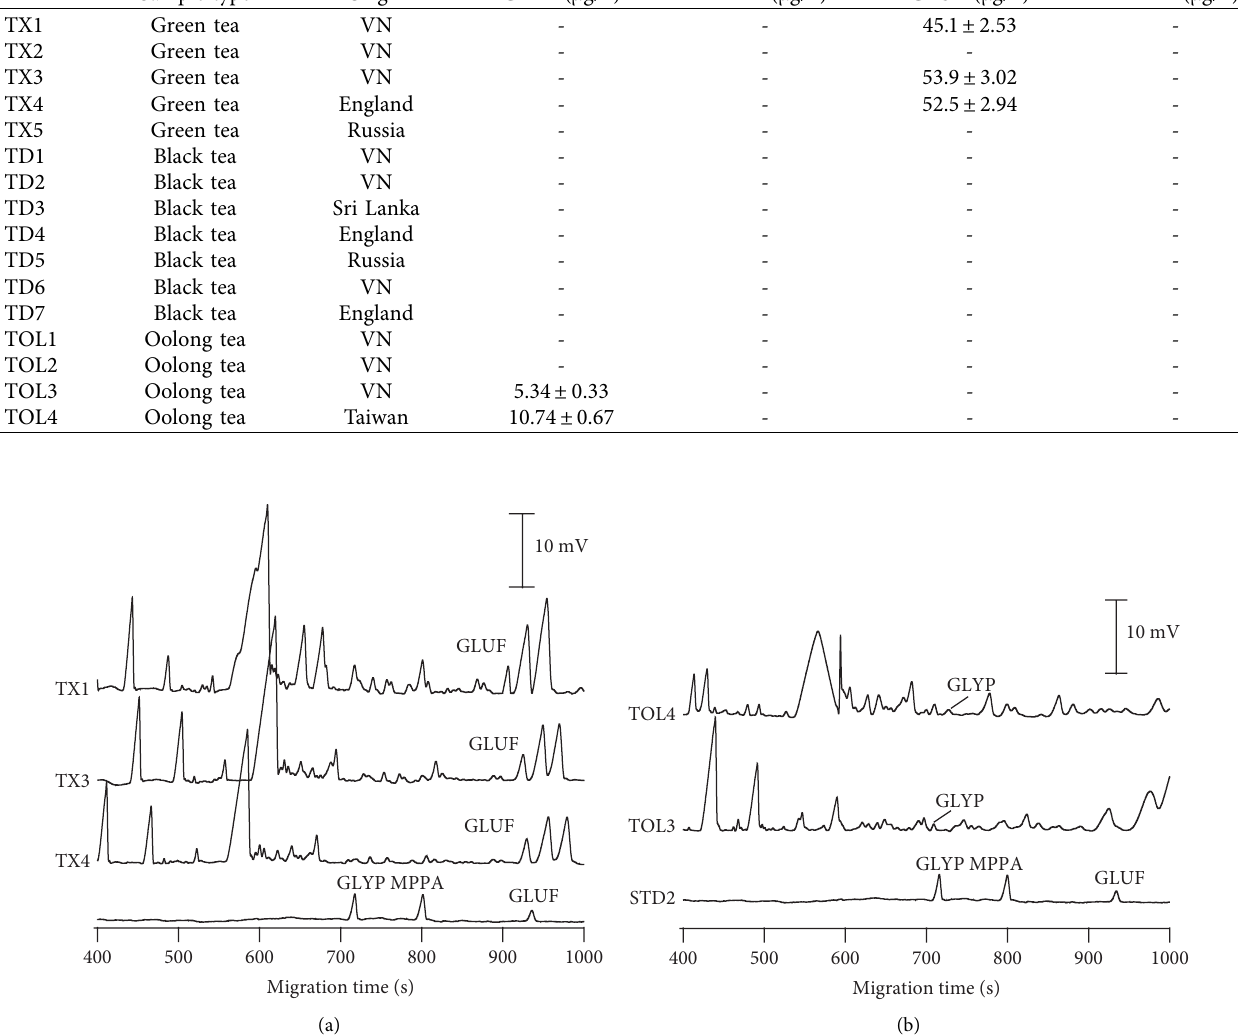
Table 3: Contents of GLYP, GLUF, AMPA, and MPPA in tea infusions determined with CE-C4D and the reference methods. ID Sample type